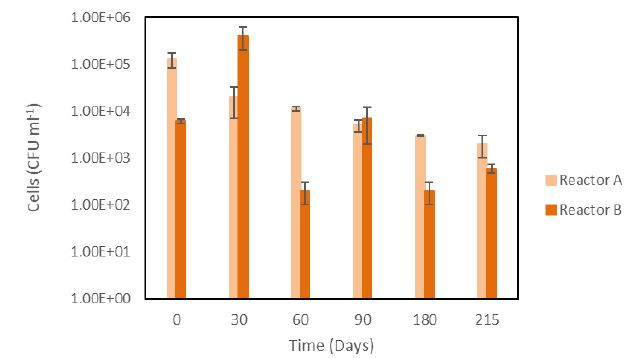
Figure 10. Monitoring of the anaerobic microbial population in SDES biological bioreactors (A and B) operated in continuous flow mode with AMD feeding.